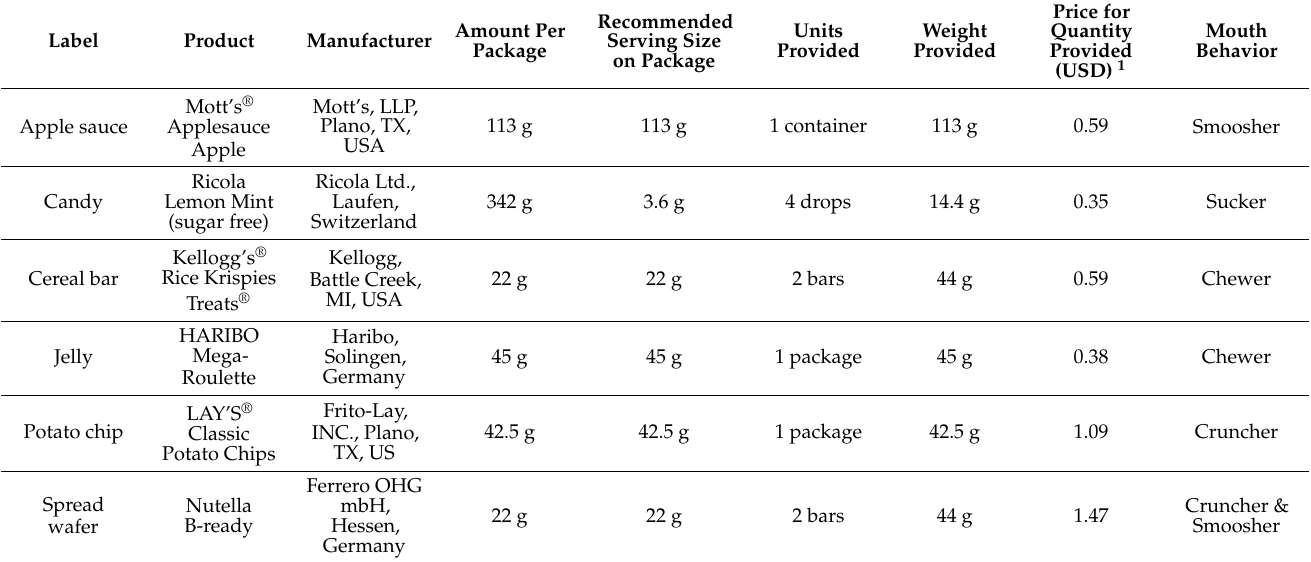
Table 2. Information of six samples evaluated.